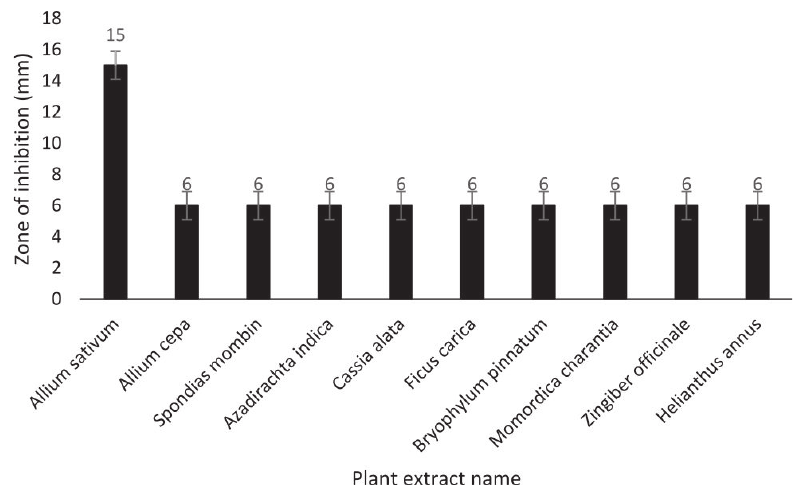
Fig. 4. Graphical representation of plant extracts and their zone of inhibition Legend: Mean±SE=mean and standard error, Resistant=<10 mm; Intermediate =10-15 mm; Susceptible=>15 mm